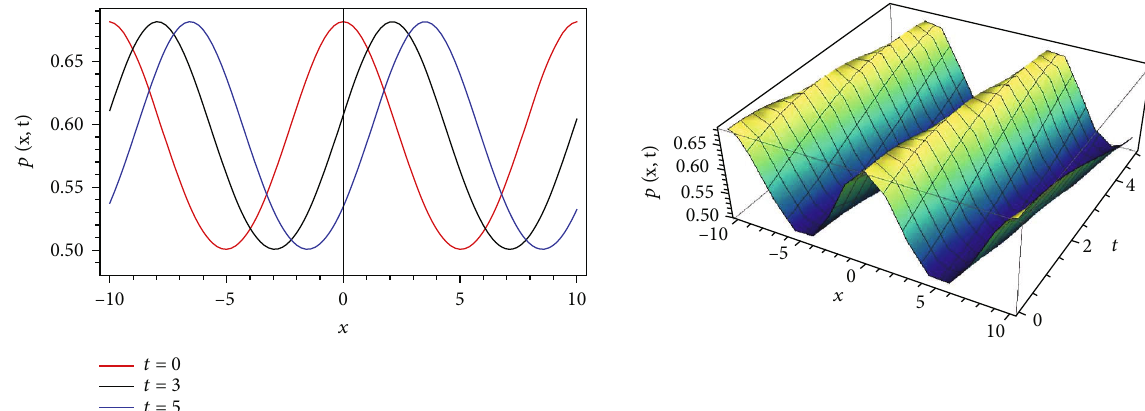
: 2, β : 7, γ : 2, k = 0 : 4, α = 0 : 7, λ = 0 : 1, μ = 0 : 1, h j = 0 j = 0 j = 0